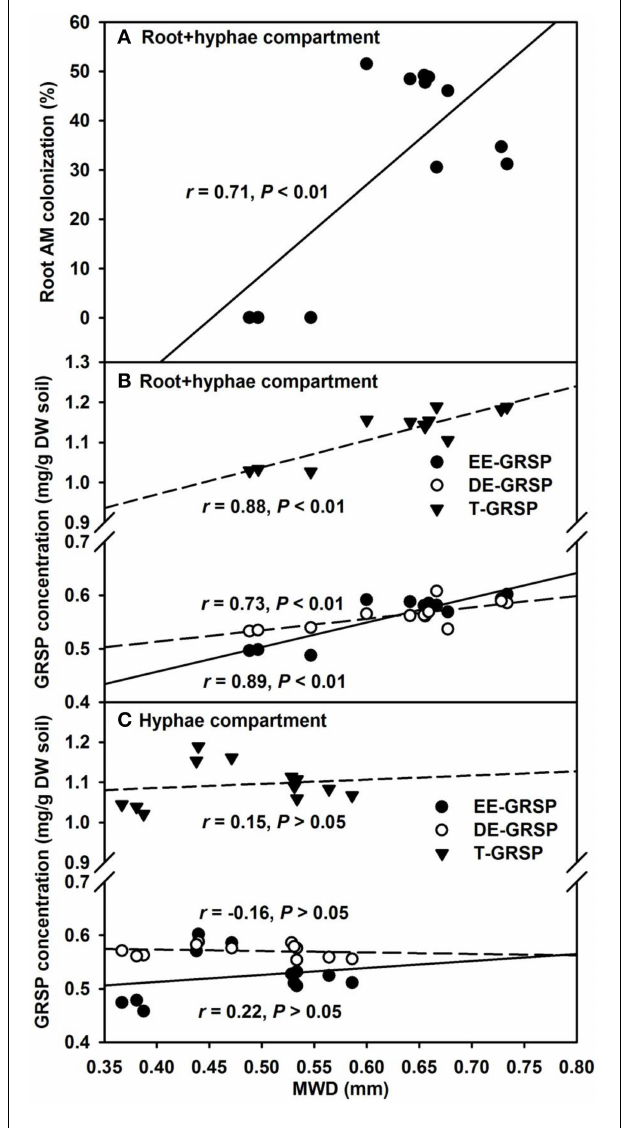
FIGURE 7 | Linear regression between mean weight diameter (MWD) and root AM colonization (A) or three glomalin-related soil protein (GRSP) fractions (B and C) of 37 µ m nylon-mesh separated root/hyphae compartments in trifoliate orange ( Poncirus trifoliata ) seedlings inoculated with or without Funneliformis mosseae ( n = 12